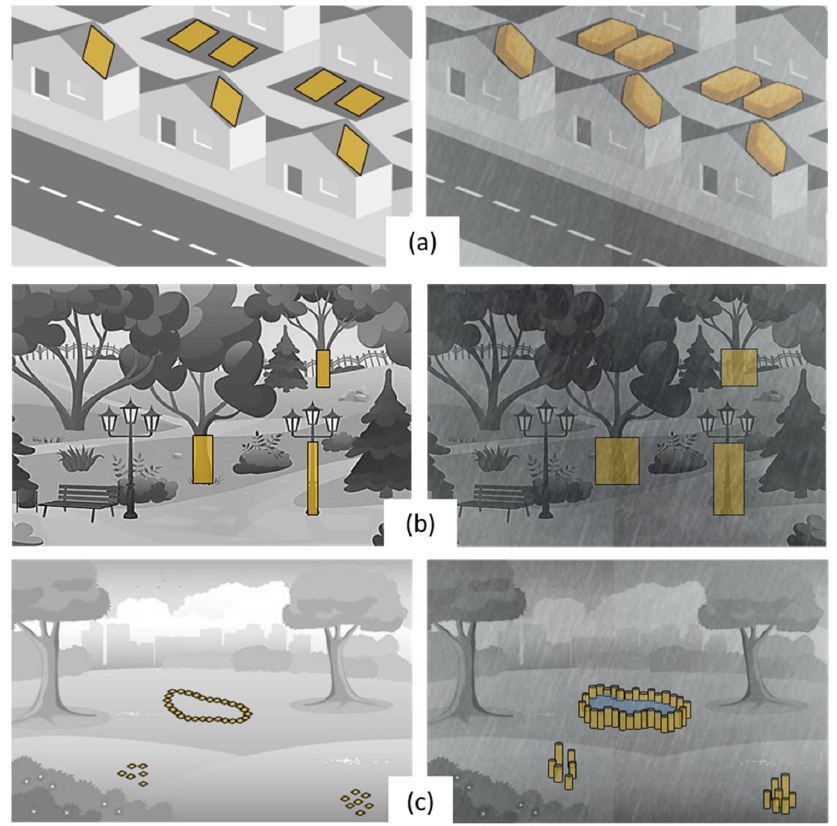
Figure 1. Theoretical concepts: ( a ) Down-flow sponge-like porous bodies (SPB) storage; ( b ) Up-flow SPB storage with the pre-installed vertical structures expanding horizontally; and ( c ) Up-flow SPB storage with new vertical structures growing up from the ground when absorbing water. Note that the SPB storage sketches presented in the figure are intended just to elucidate the theoretical concept of such storage, without any aesthetic, practical or placement